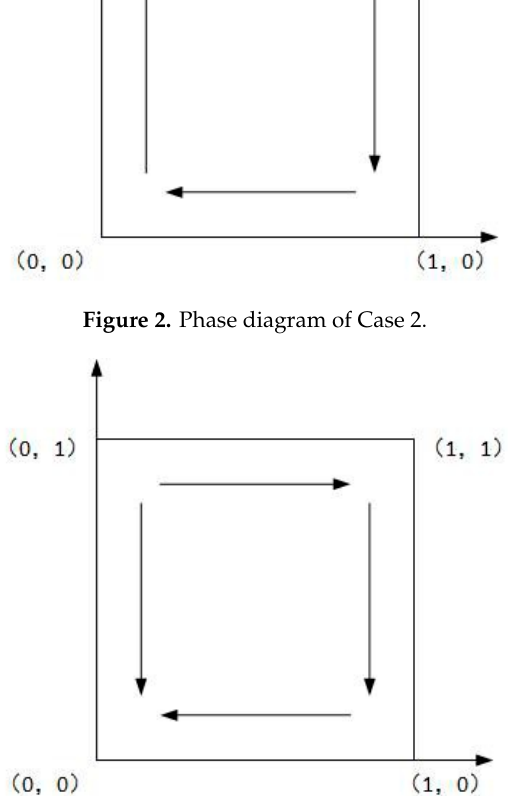
Figure 3. Phase diagram of Case 3.